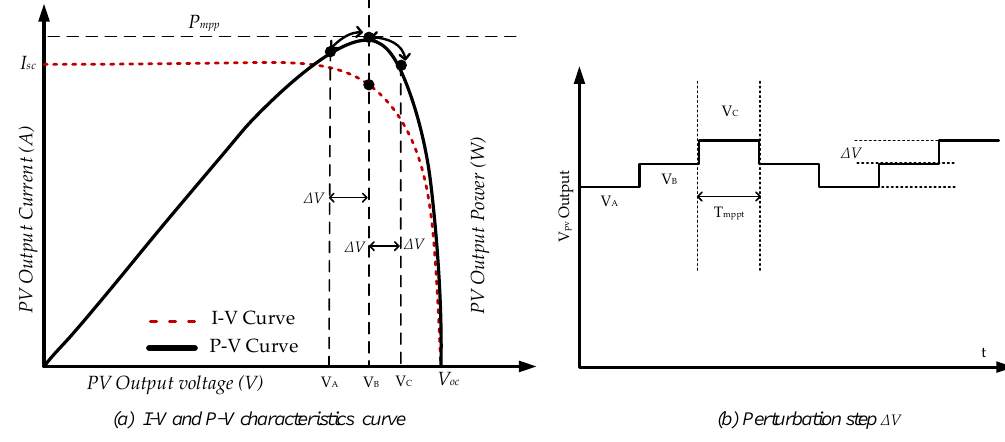
Figure 1. P&O MPPT algorithm operation.